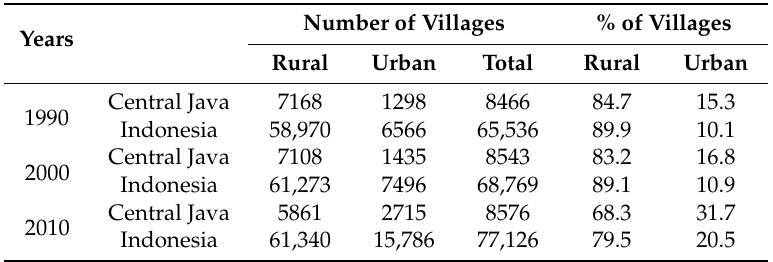
Table 4. Composition of urban and rural villages in 1990, 2000, and 2010.